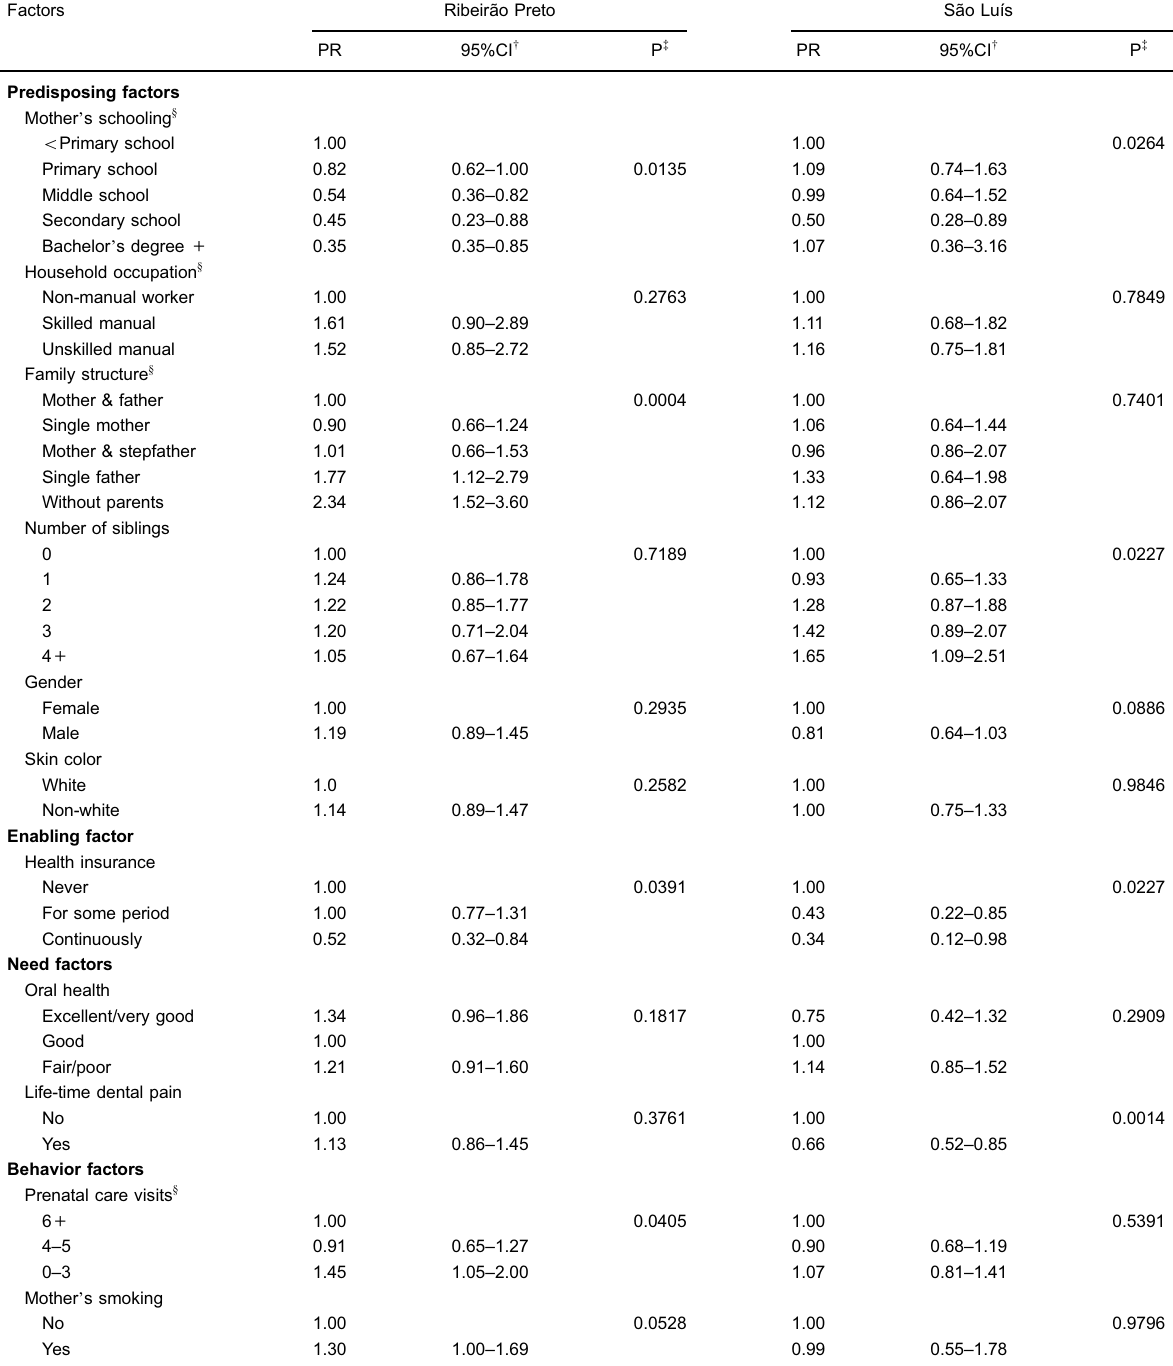
Table 4. Final multivariable analysis results showing prevalence ratios (PR) for covariates for children who did not visit a dentist before the age of 7 in the Ribeirão Preto and São Luís cohorts (2004/2005).